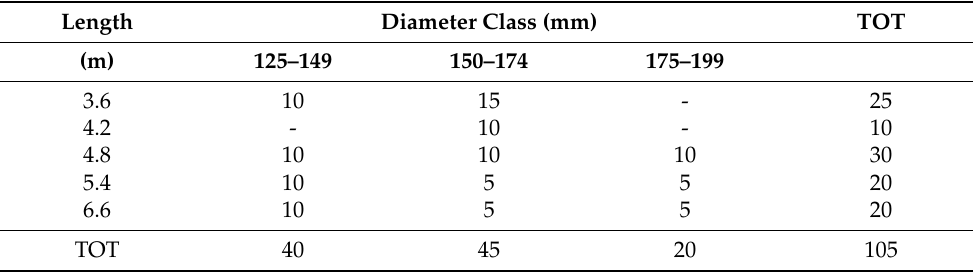
Table 1. Description of the sample: number of pieces for diameter class and length.